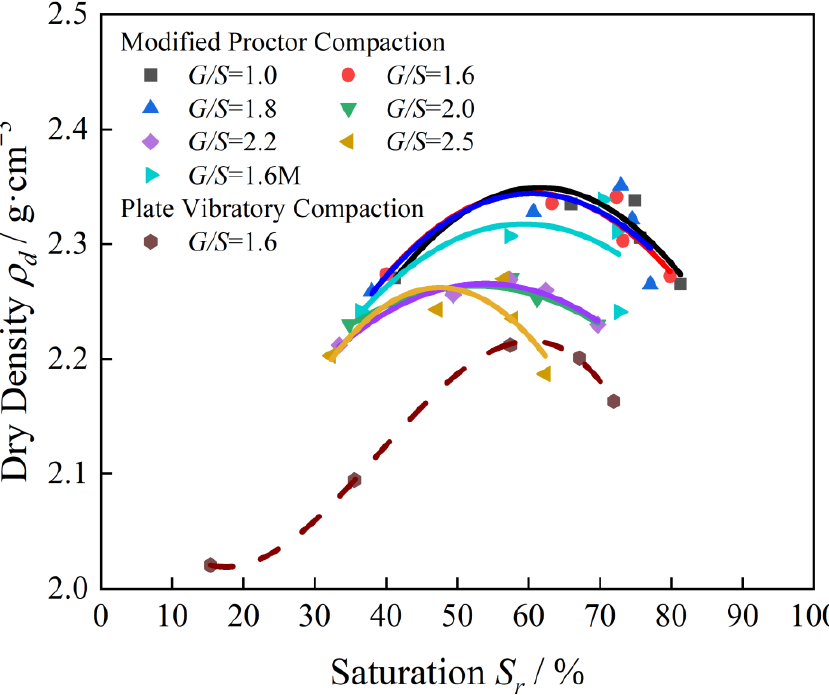
Figure 18. The curves of achieved dry density versus degree of saturation of UPAB specimens with different G/S values.